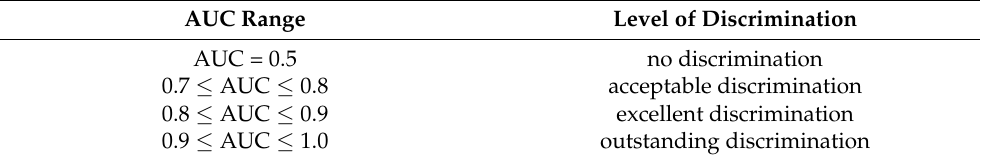
Table 3. Description of AUC range.